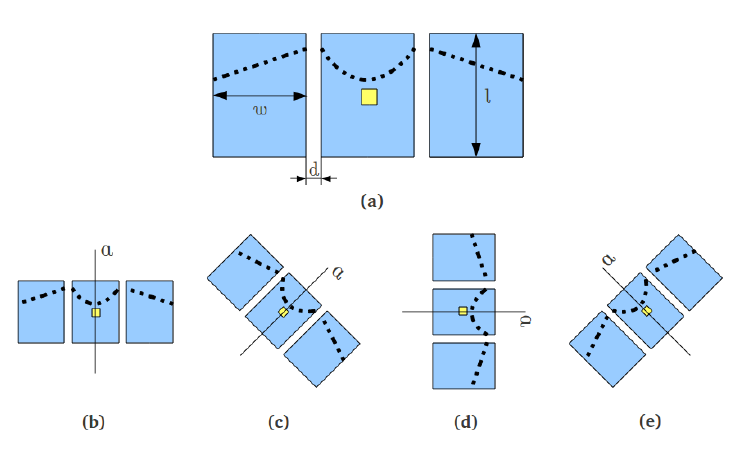
Figure 3. (a) The three considered regions for the ANOVA evaluation. ( w, l ) represent the window size, d is the displacements between windows. The last row reports the four directions, denoted by the angle a , where the ANOVA is applied: (b) a = 0 ◦ , (c) a = 45 ◦ ,(d) a = 90 ◦ ,(e) a = − 45 ◦